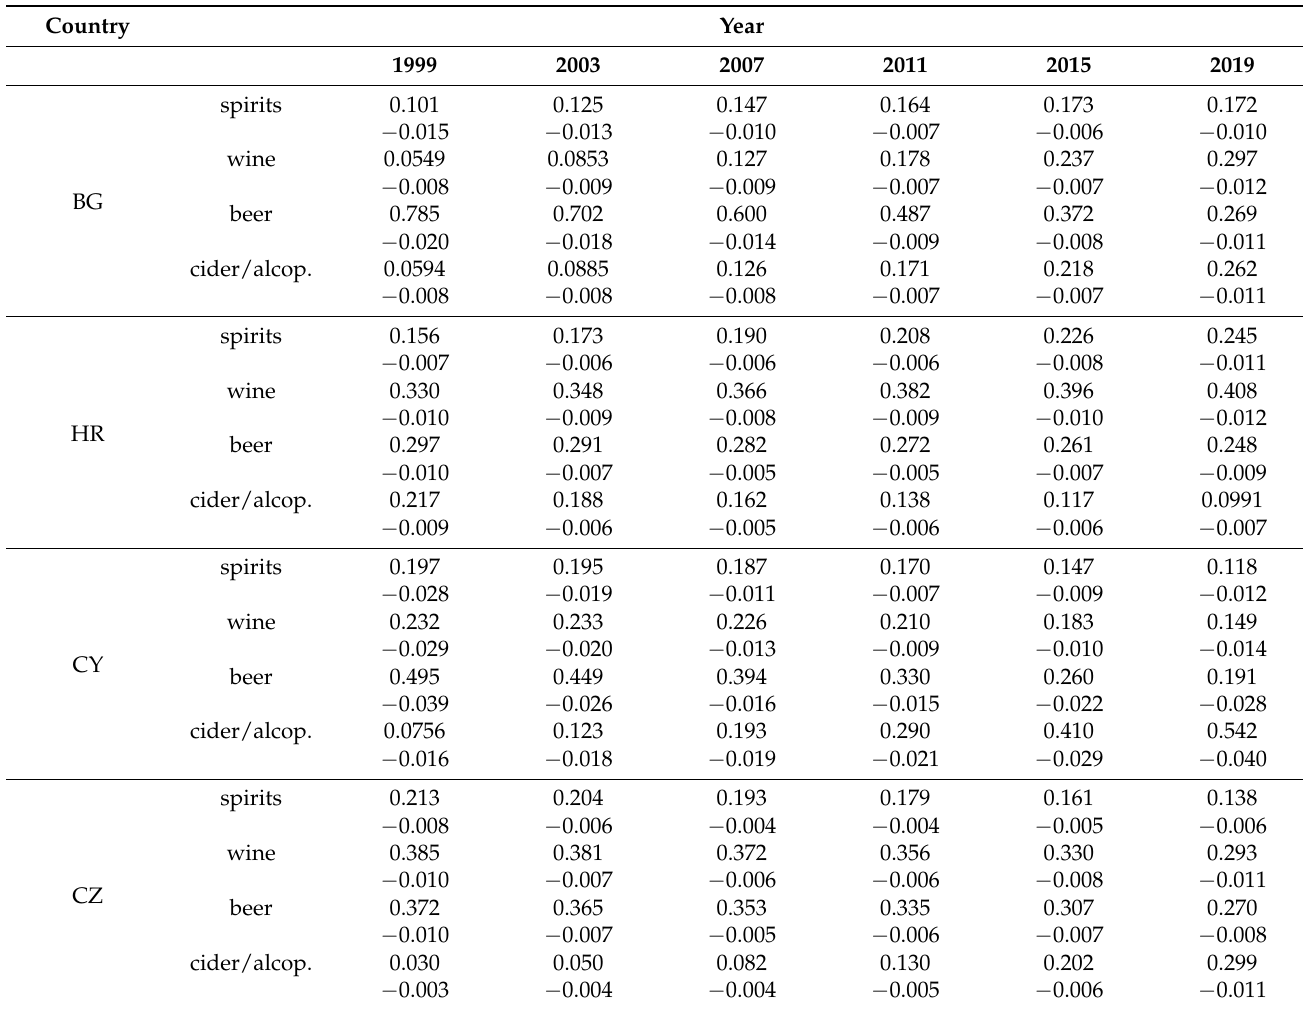
Table A5. Model predictions of beverage proportions for girls, 1999–2019 (margins,